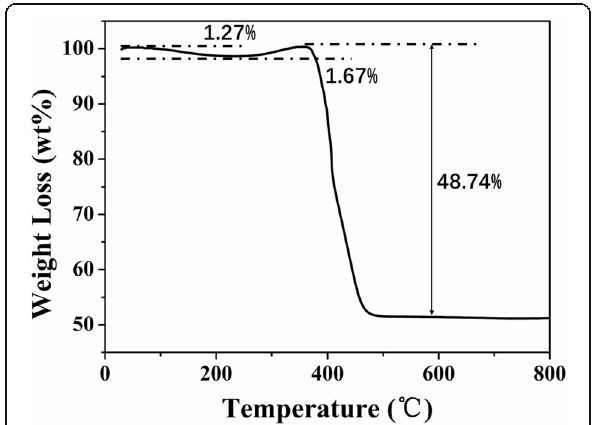
Fig. 4 TG curves of CoFe@C